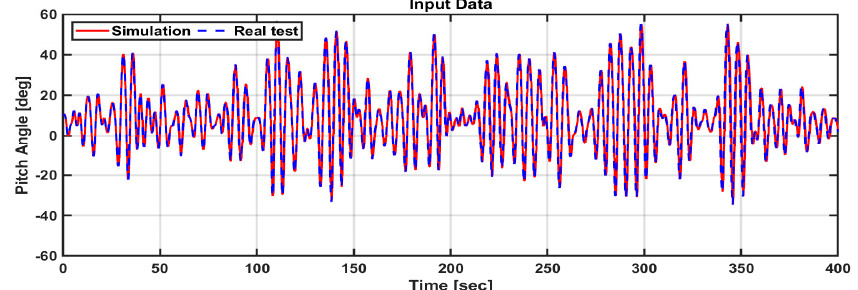
Figure 27. Simulator input data results obtained using pitch angle data of a floating body in an actual sea